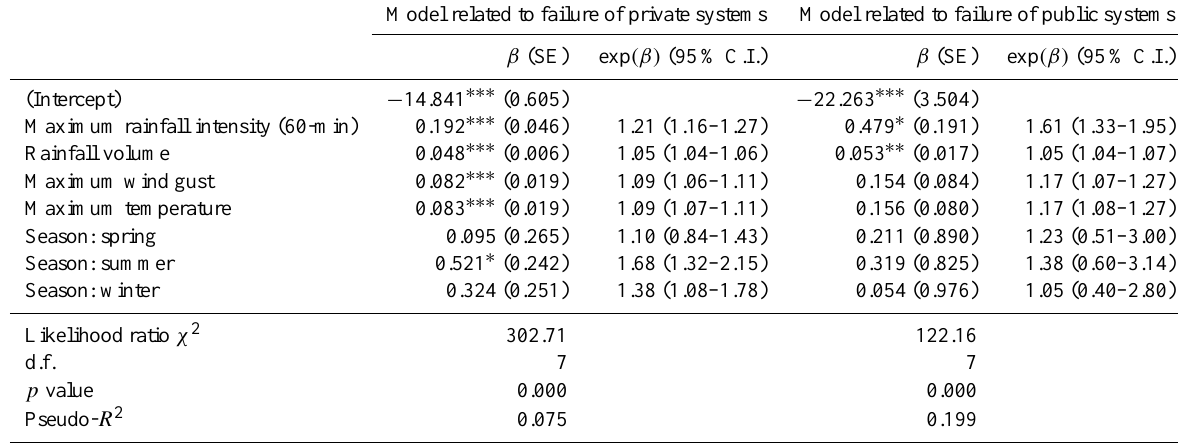
Table 6. Estimates of regression coefficients of the rare event logistic regression models. Model related to failure of private